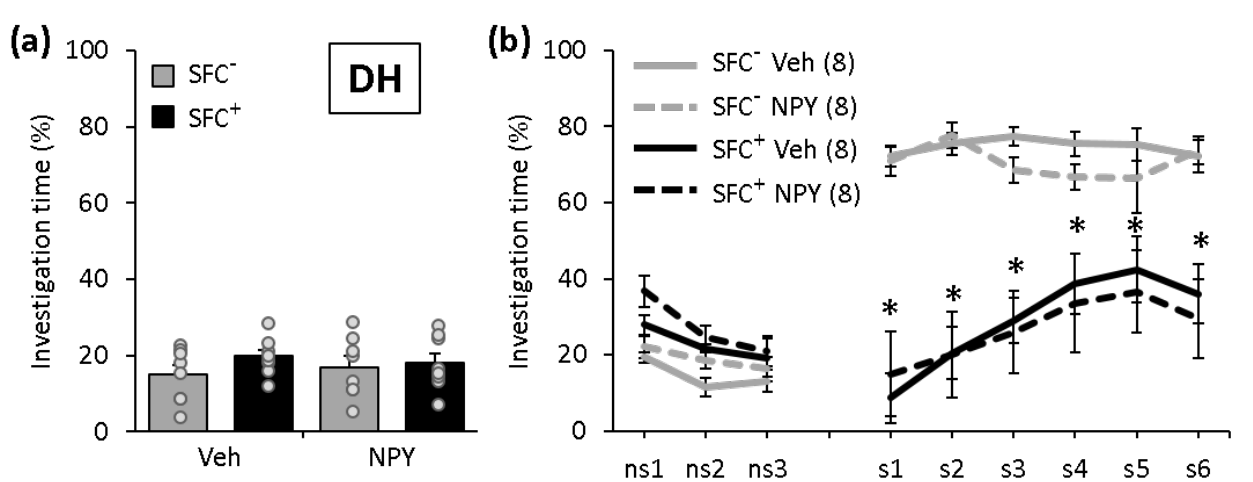
Figure 1. Neuropeptide Y (NPY) does not affect the expression of social fear when administered into the dorsal hippocampus (DH). ( a ) Pre-conditioned investigation of the non-social stimulus (empty cage) during social fear conditioning (SFC) on day 1. ( b ) Investigation of the non-social (ns1–ns3) and social (cages with mice; s1–s6) stimuli during social fear extinction on day 2. Unconditioned (SFC − ) and conditioned (SFC + ) mice were administered either vehicle (Veh; 0.2 µ L/side) or NPY (0.1 nmol/0.2 µ L/side) 10 min before social fear extinction. Data represent means ± SEM and numbers in parentheses indicate group sizes. p < 0.05 * vs. respective SFC − controls.